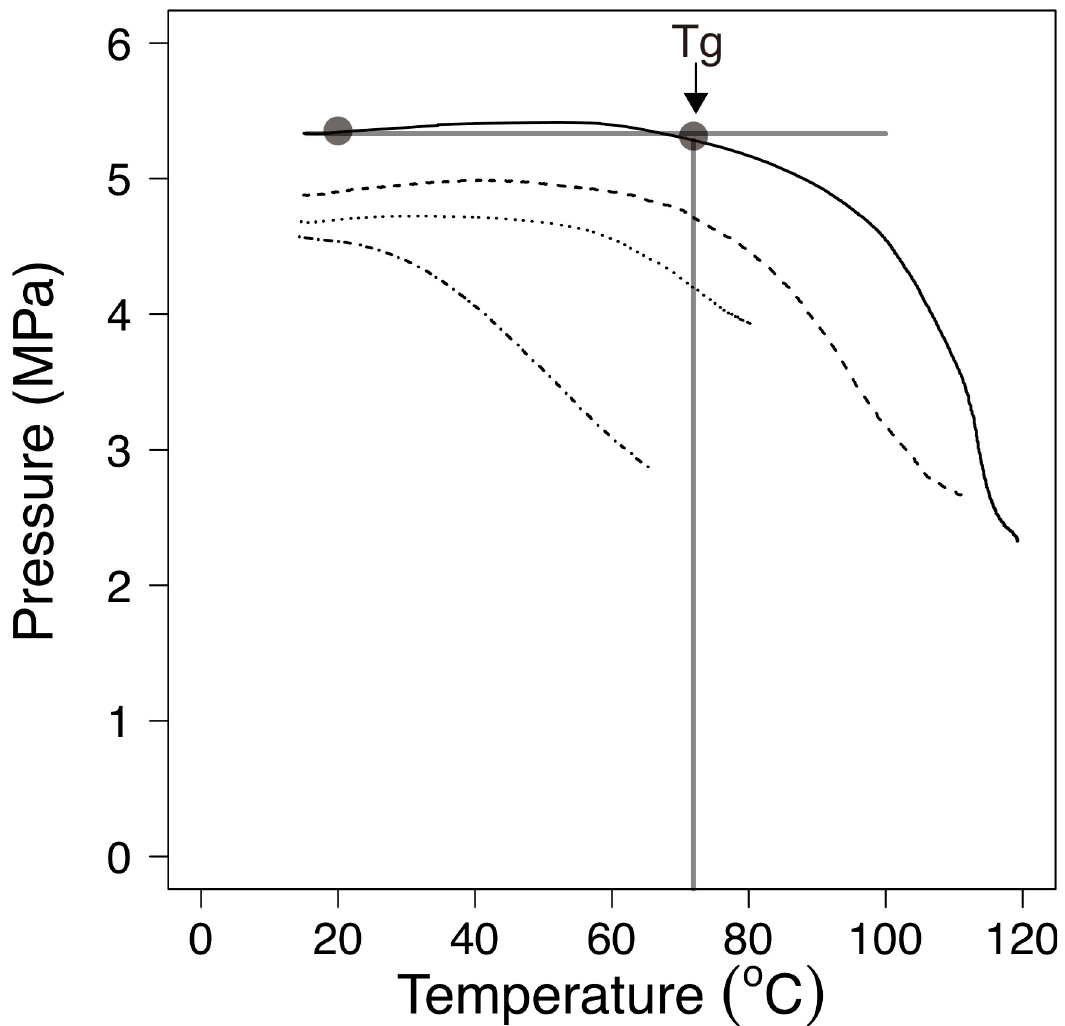
Fig 2. Measurement of glass transition temperature ( T g ) of Salmonella Typhimurium at a w = 0.43 (solid line), 0.57 (dashed line), 0.75 (dotted line), and 0.87 (dot dashed line) using thermal rheological analysis. The onset temperature of the pressure reduction was regarded as the T g of the sample as shown in the